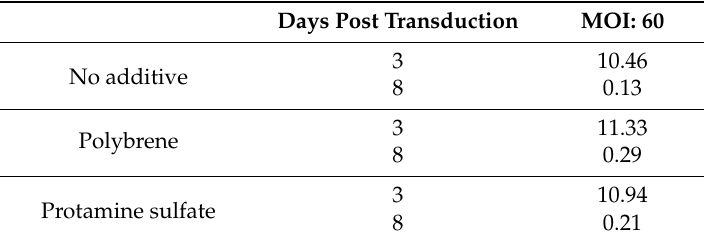
Table 3. Comparative vector copy number analysis of transduced macrophages, by quantitative PCR, at two different time